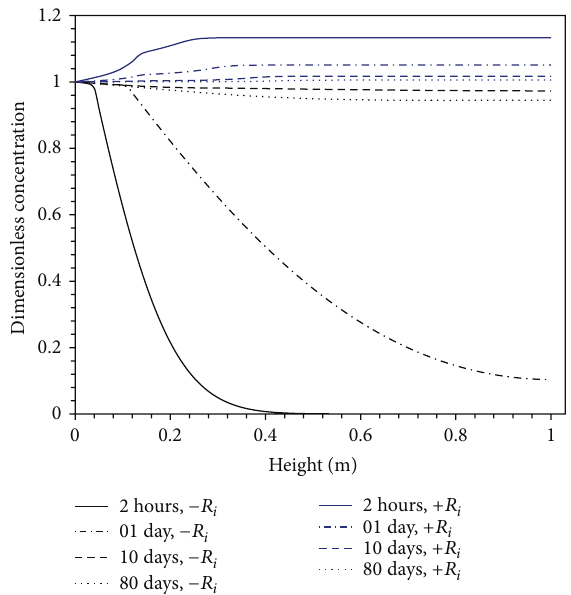
Figure 2: Water saturation against the height with various imbibi- tion times and inlet concentrations. Figure 3: Normalized particles concentration against height with positive/minus 𝑅 𝑖 and various imbibition